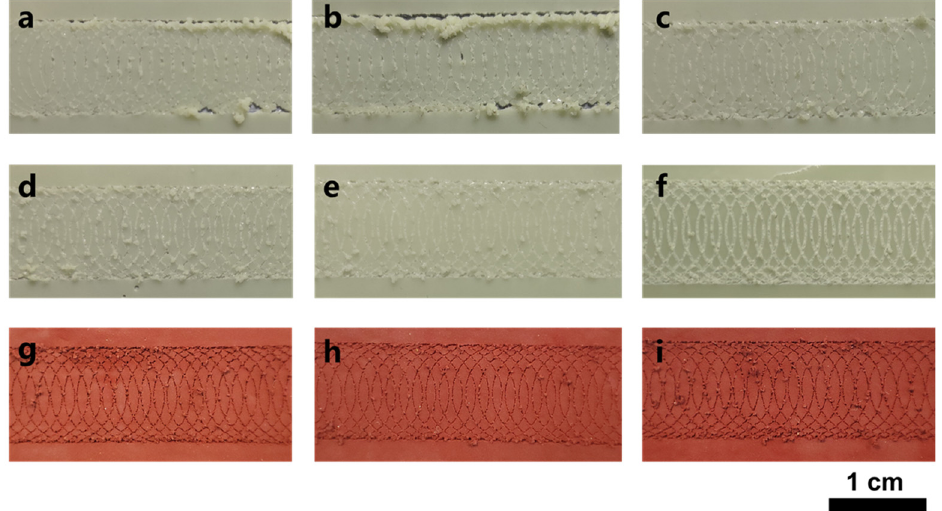
Figure 3. The change in the coating adhesion when samples were dried at room temperature and under different drying times. ATH 20 wt.% drying time: ( a ) 7 days, ( b ) 14 days, ( c ) 21 days, ( d ) 28 days, ( e ) 35 days, ( f ) 90 days; RP 20 wt.% drying time: ( g ) 3 days, ( h ) 6 days, ( i ) 14 days.